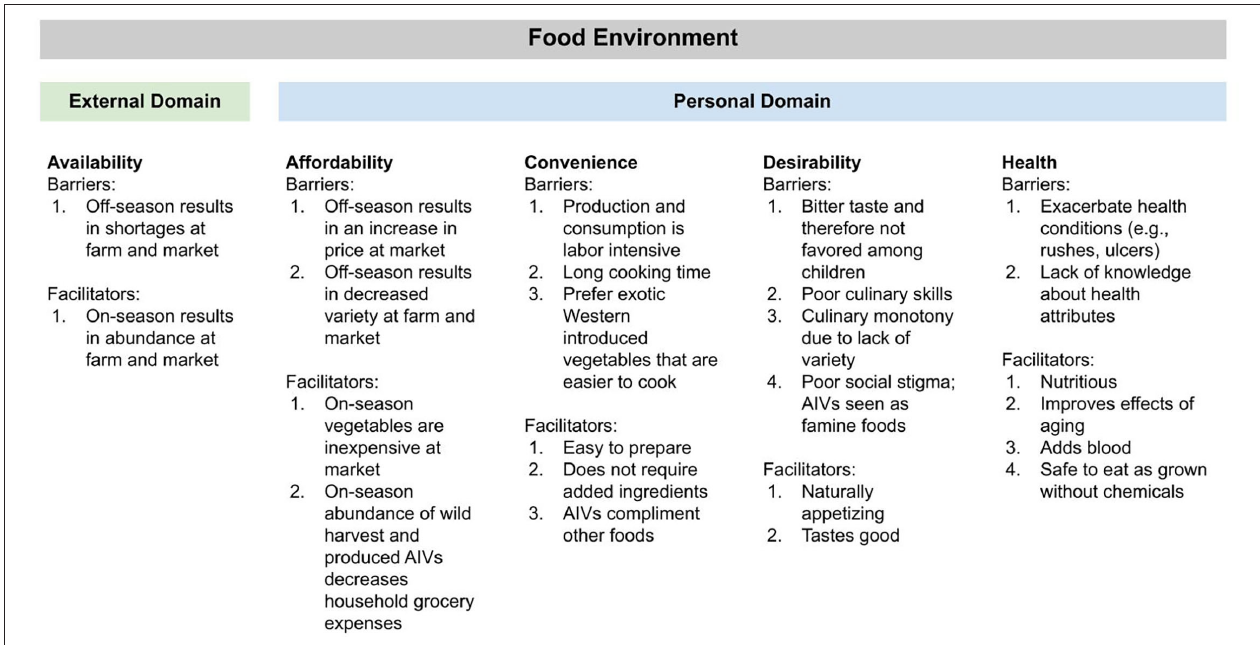
FIGURE 1 | Key barriers and facilitators to production and consumption of African Indigenous Vegetables in the external and personal food environment in Western